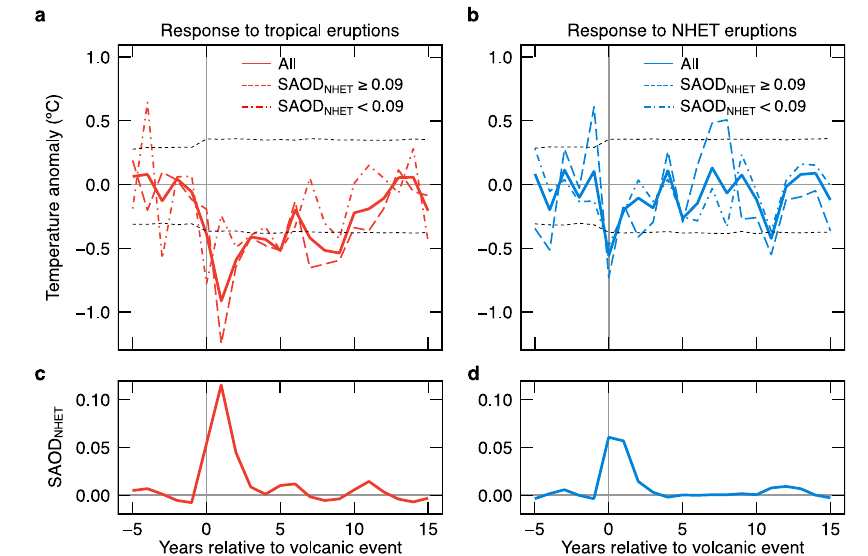
Fig. 3 | Superposed epoch analysis for D-STREC according to volcanic aerosol forcing since 1000 CE. a D-STREC responses to tropical eruptions with strato- spheric aerosol optical depth at 550nm area-weighted averaged over 30 – 90°N (SAOD NHET ) ≥ 0.03 ( “ All ” ), SAOD NHET ≥ 0.09, and 0.03 ≤ SAOD NHET <0.09. b Same as a but for Northern Hemisphere extratropical (NHET) eruptions. c Superposed